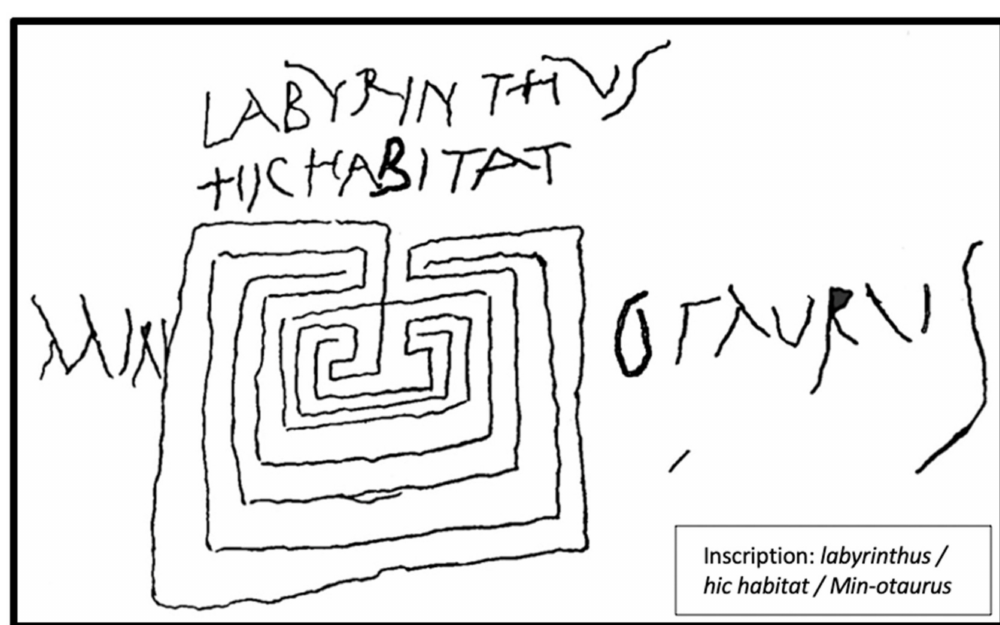
Figure 2. Labyrinth from the Marco Lucrezio’s House in Pompeii, Italy (courtesy of Recuperando Srl, Forte dei Marmi,